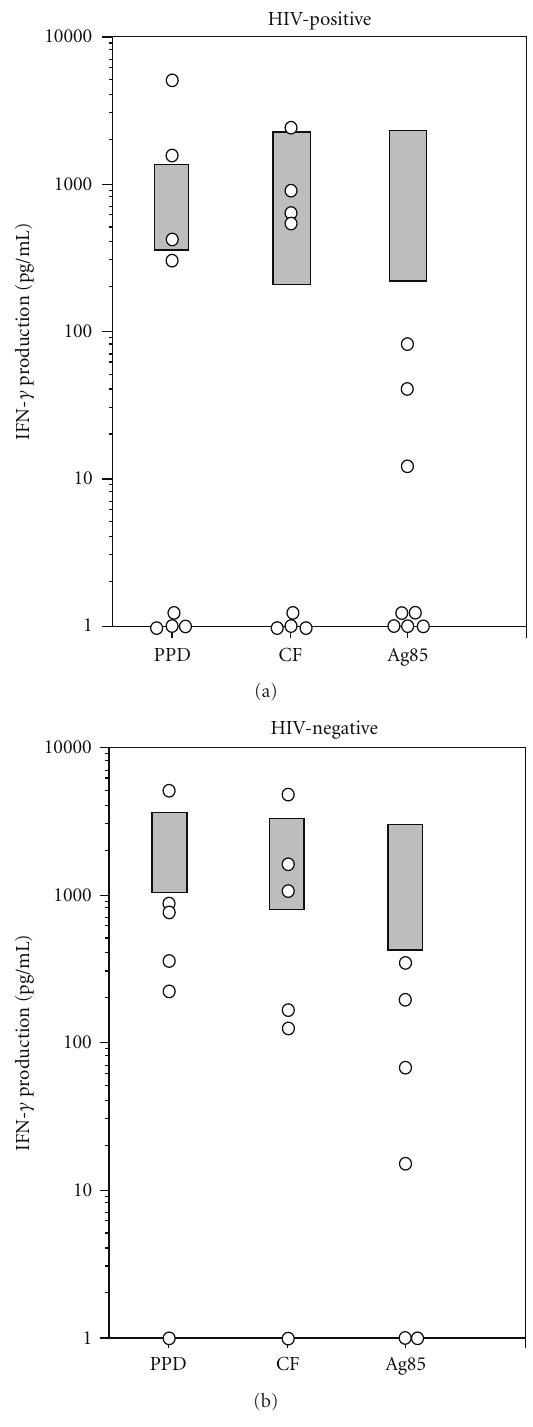
Figure 3: Individual IFN- γ production (pg/mL) by PBMC in response to di ff erent antigens from HIV-positive (a) or HIV- negative (b) patients with active tuberculosis. A negative response was considered as less than mean − 2SD of the IFN- γ production by PBMC from tuberculin-positive/HIV-positive (a) and tuberculin- positive/HIV-negative (b) controls. The circle patients with active tuberculosis. The grey rectangle mean ± 2SD of the IFN- γ produced by PBMC from tuberculin-positive/HIV-positive or HIV-negative